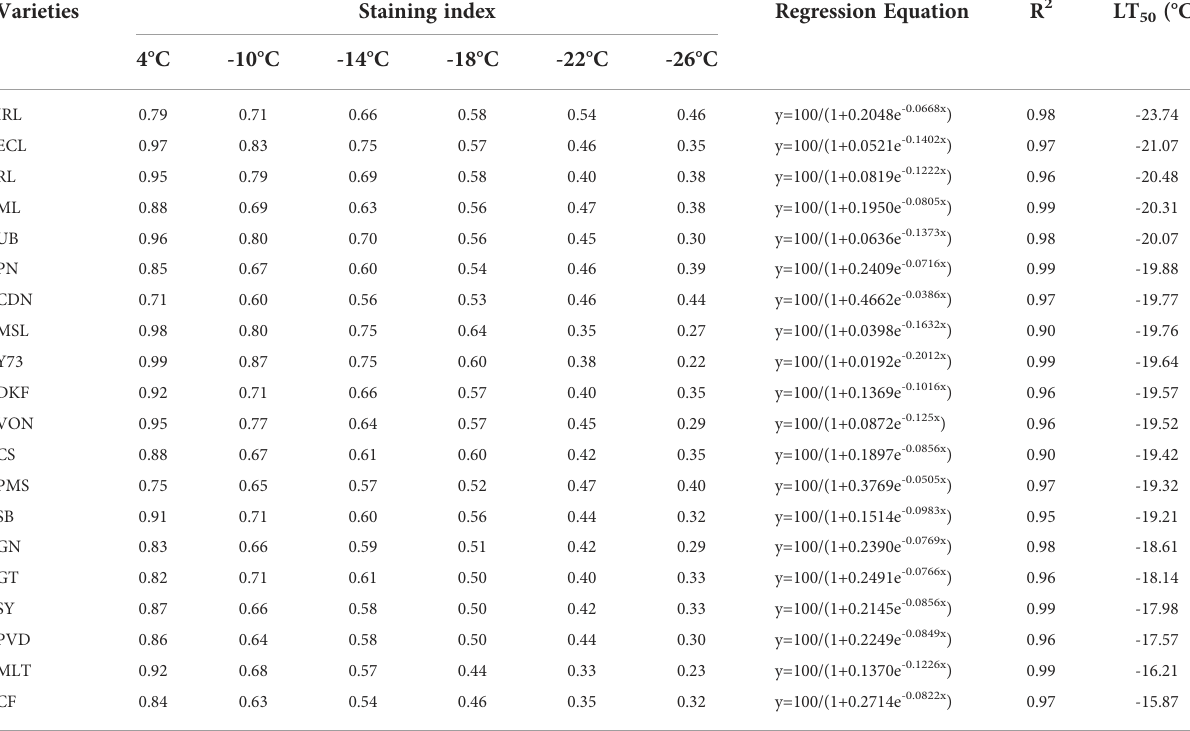
TABLE 3 Identi fi cation of cold resistance in 20 V . vinifera varieties based on TTC.